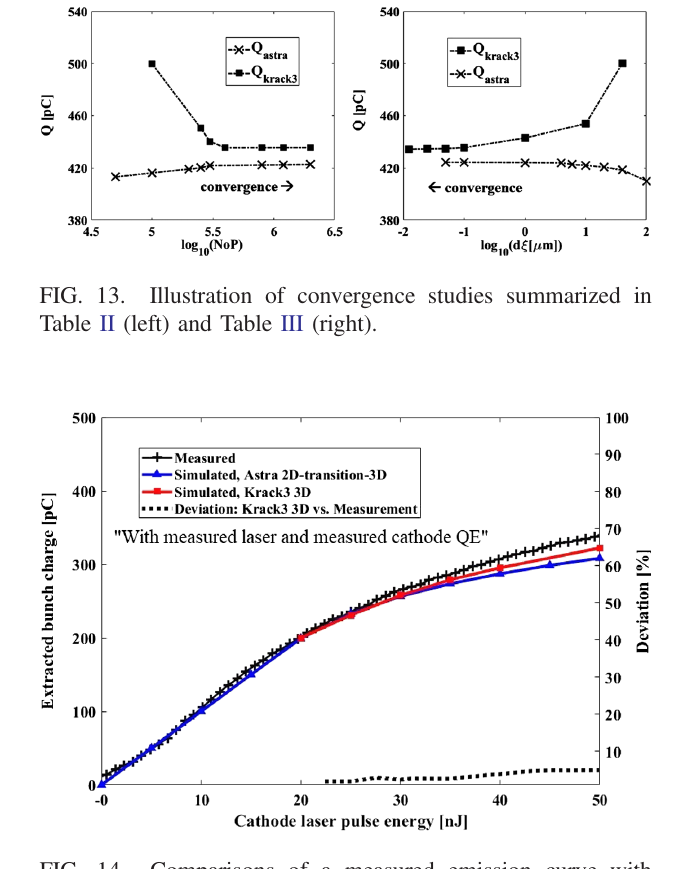
FIG. 14. Comparisons of a measured emission curve with different numerical approaches using an asymmetric electron bunch produced at cathode according to Sec.